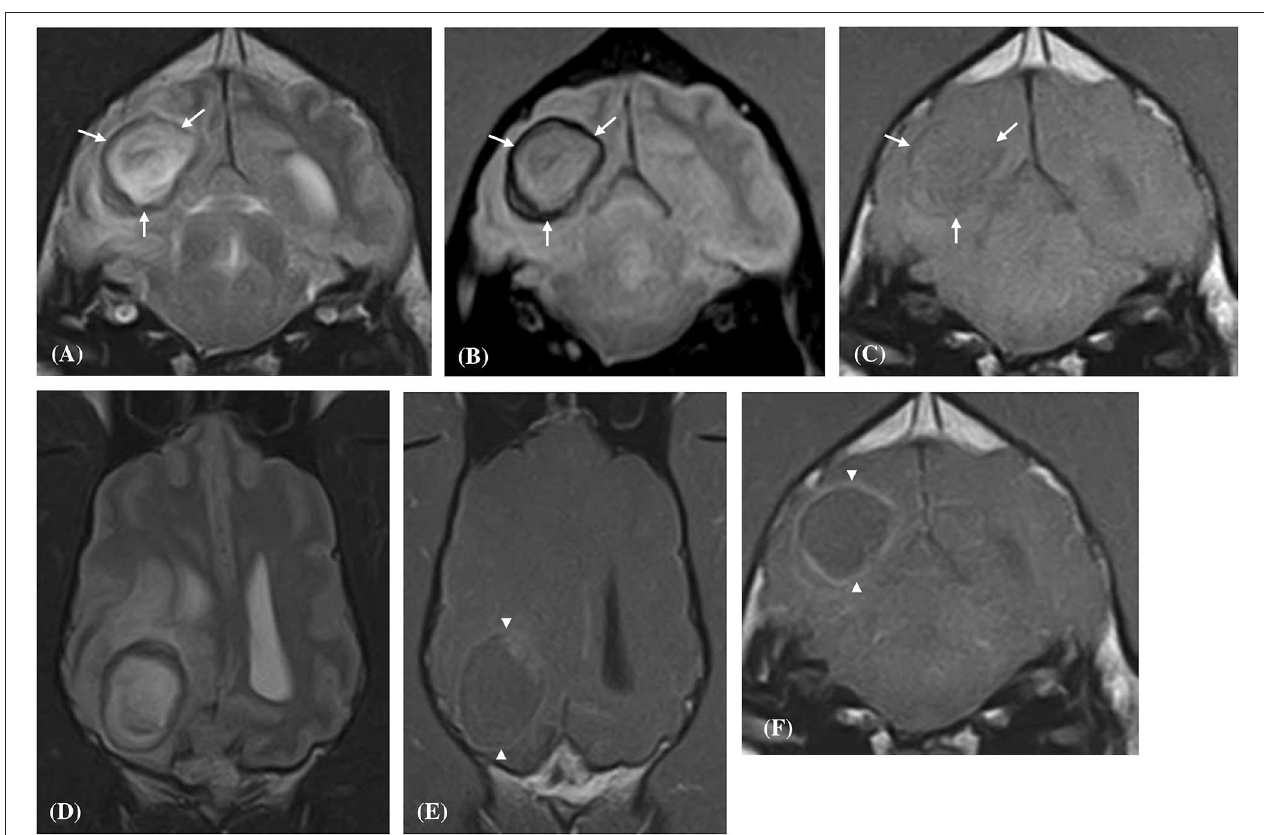
FIGURE 2 | Transverse (A–C,F) and Dorsal (D,E) magnetic resonance images of a dog (Case 6) with a solitary well-defined intracranial intra-axial hematoma affecting the white matter of the right occipital lobe and associated perilesional oedema. The lesion displays a clear regional dichotomy with a hypointense thin, complete, circumferential peripheral border region (white arrows) and a large central predominately hyperintense region (relative to gray matter) on T2-weighted (A,D) , T2* gradient-echo (B) images. On pre-contrast T1-weighted images the peripheral border region is again hypointense (C) but is thinner relative to the T2-weighted images. Following contrast administration, the hematoma displays a thin peripheral enhancement pattern (white arrow heads) with no enhancement of the central portions of the lesion (E,F) .